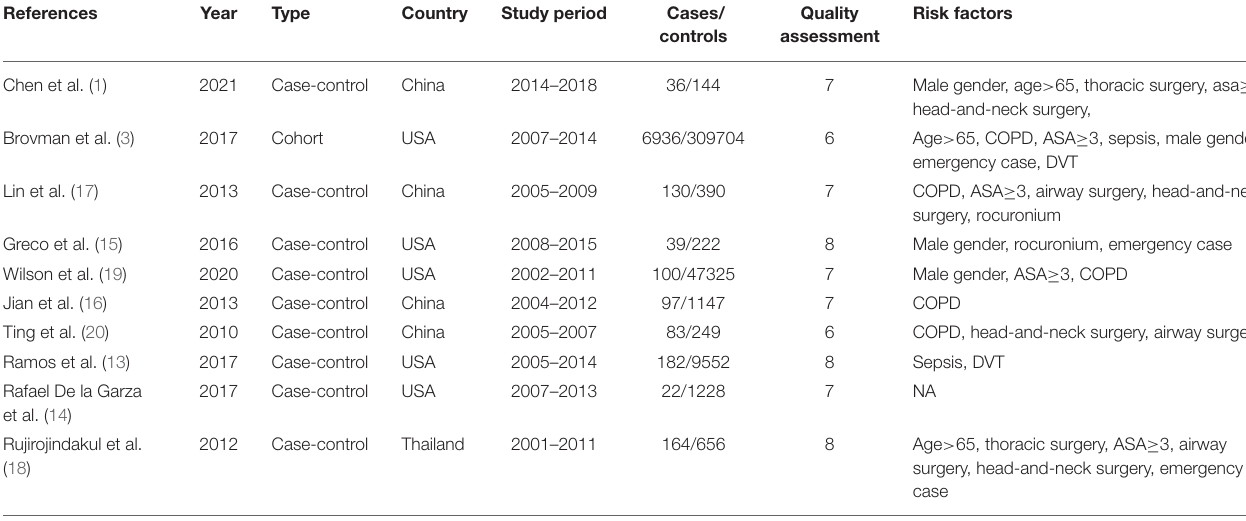
TABLE 3 | Characteristics of studies included in the meta-analysis.